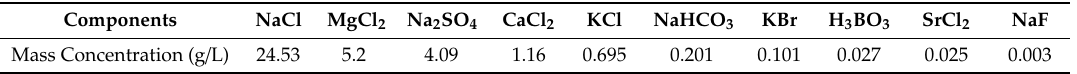
Table 2. Chemical components of artificial seawater